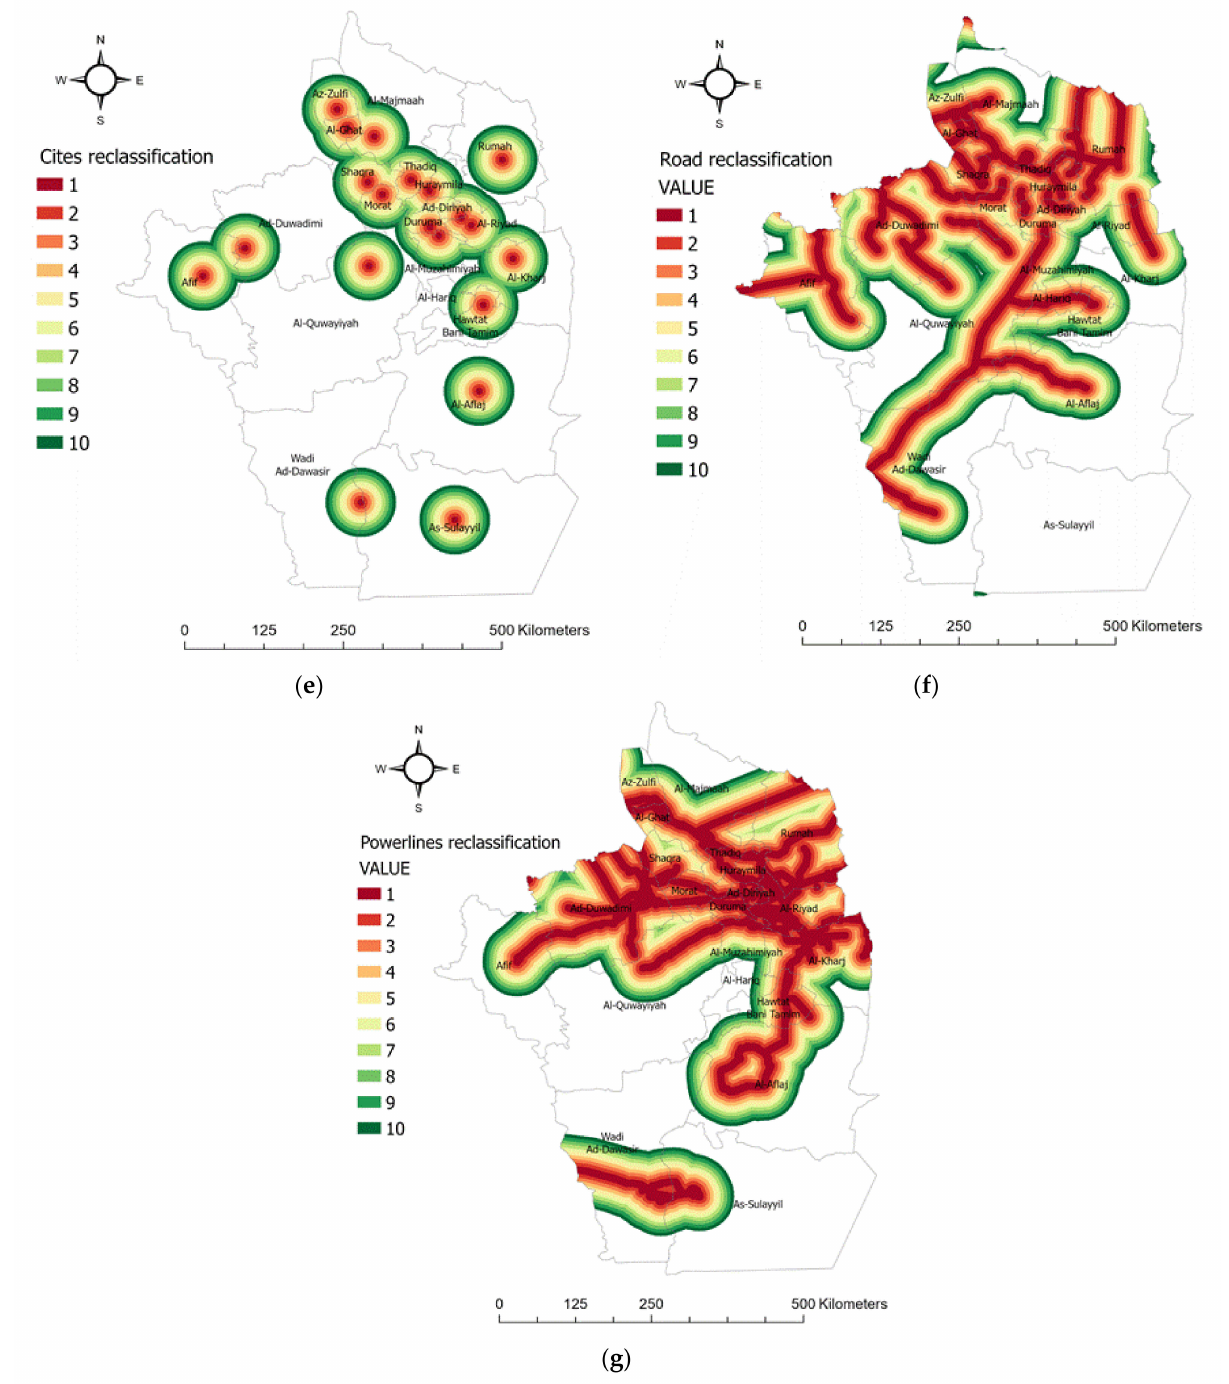
Figure 5. Criteria range of suitability: ( a ) temperature, ( b ) solar radiation, ( c ) slope, ( d ) aspects, ( e ) cities, ( f ) roads and ( g ) power